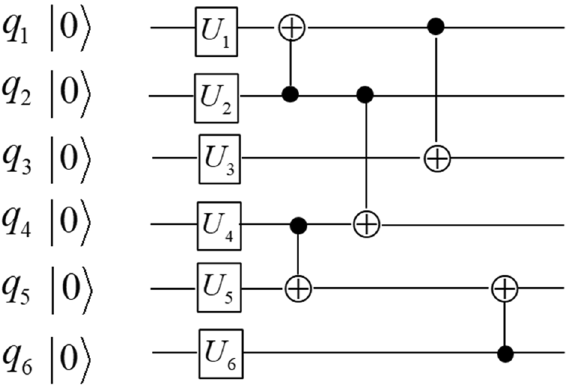
Figure 3. The quantum circuit of one layer of the hardware-efficient ansatz in Ref. 46